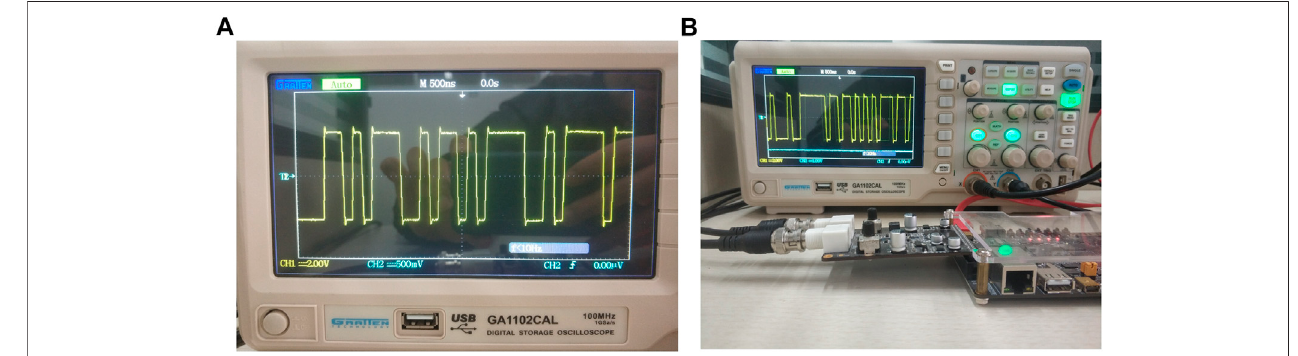
FIGURE 11 | (A) Oscilloscope waveform of PRNG based on FPGA implementation; (B) Experimental